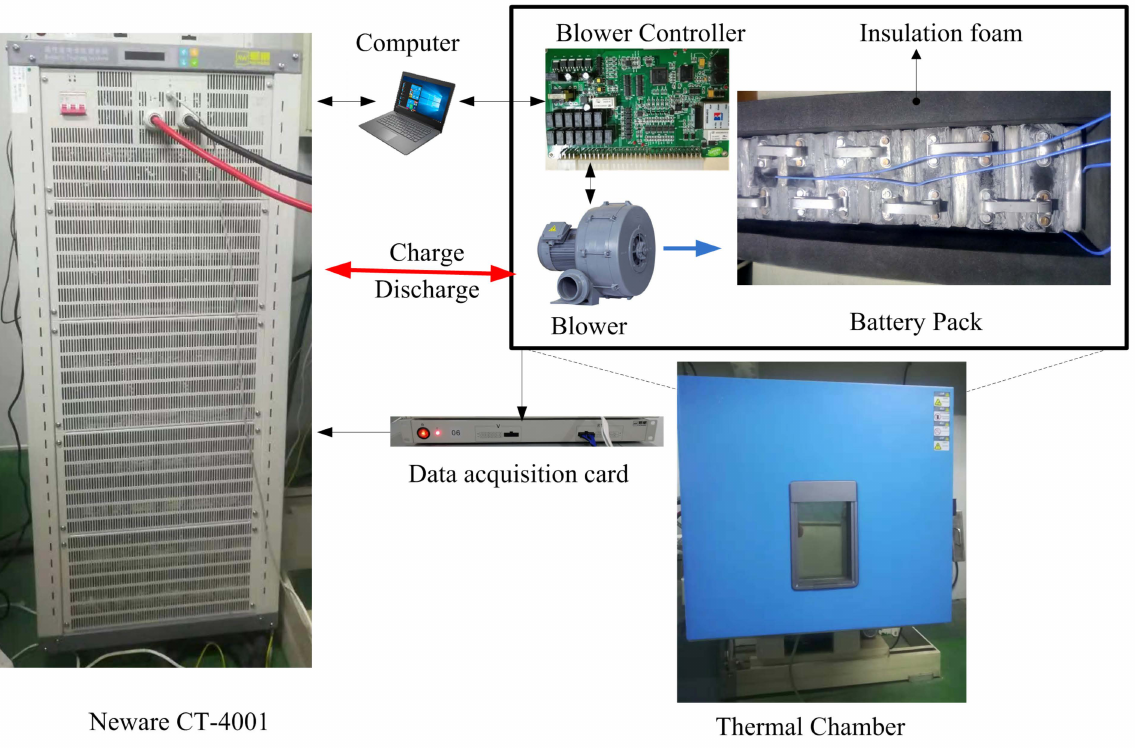
Figure 1. Experimental